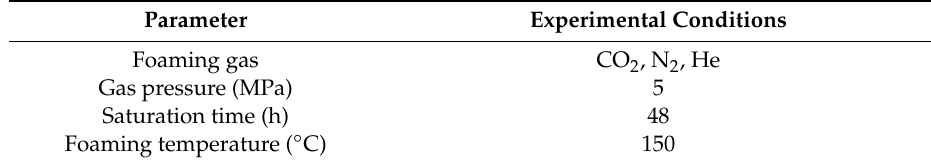
Table 2. Batch-process conditions with di ff erent foaming gases.